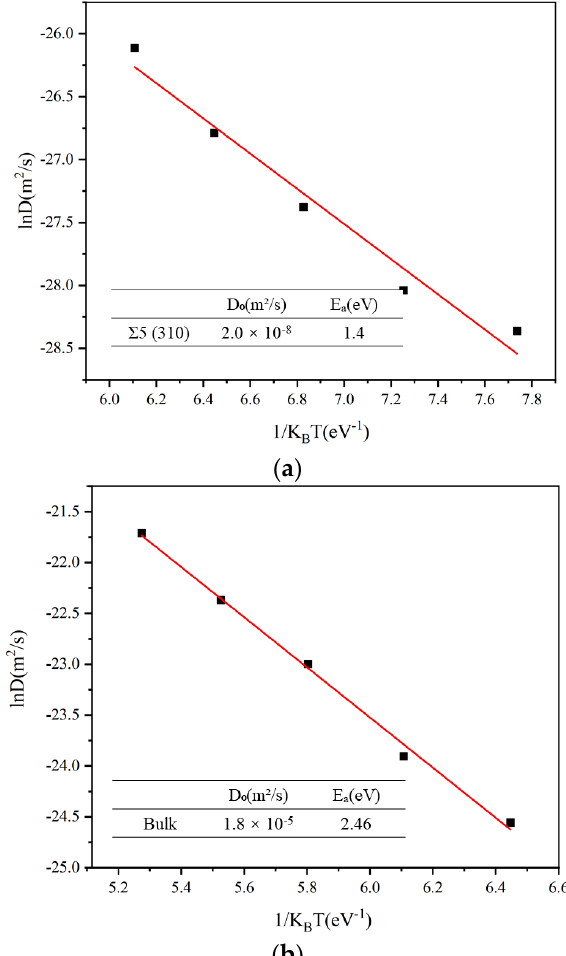
Figure 3. Diffusion coefficients of Xe ( a ) at the Σ 5 GB and ( b ) in the bulk UO 2 . The lines are linear Arrhenius fits.